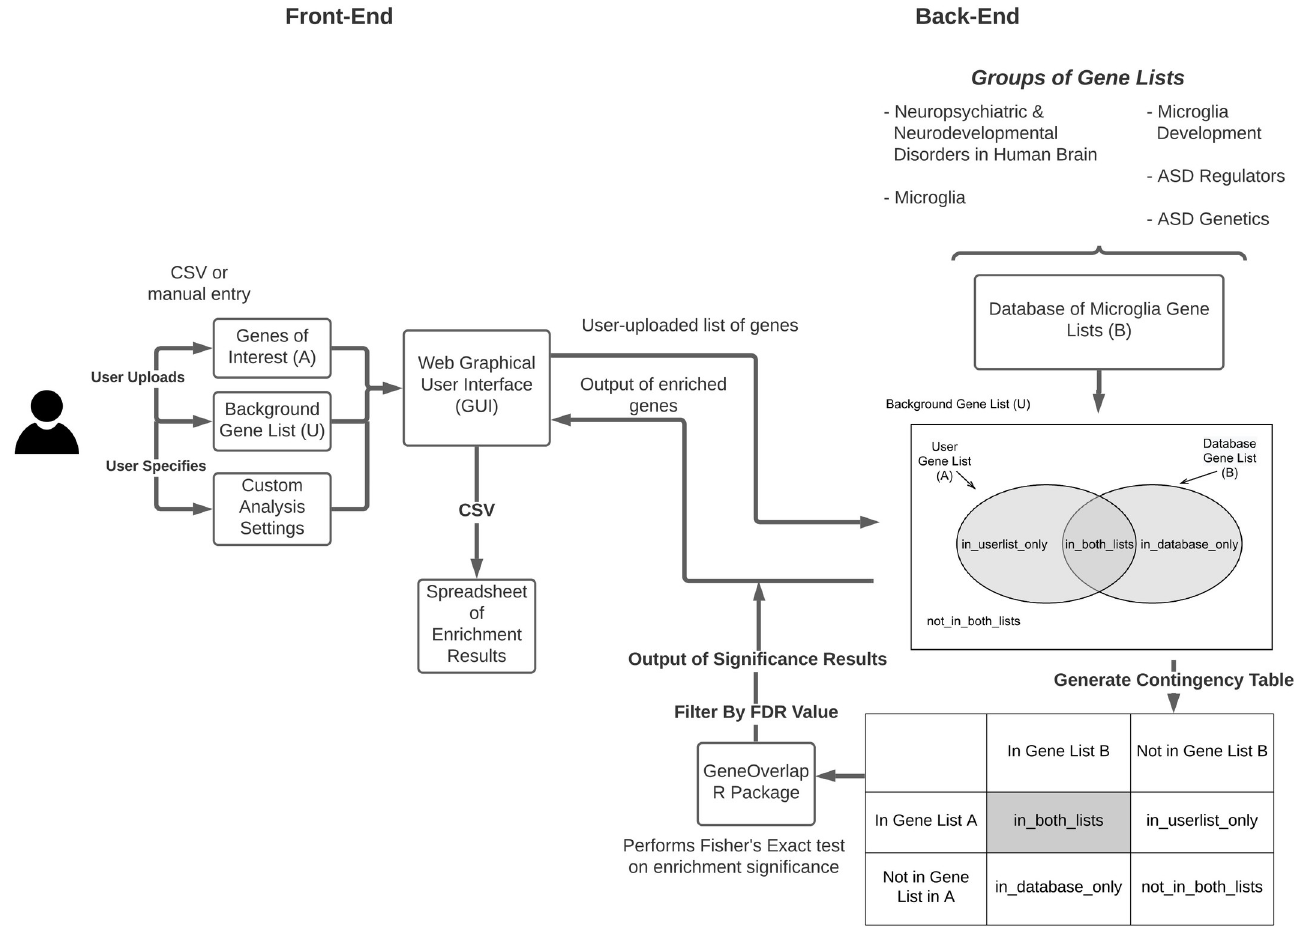
Fig 1. Model of MGEnrichment. Users can select either mouse or human gene lists and upload their gene lists of interest either through a CSV file or through entry into the GUI. The input dataset is compared against the database of microglia gene lists to determine enrichment. The GeneOverlap package is used to calculate a one-tailed Fisher’s Exact Test for enrichment in each gene list, and FDR corrected p-values are then calculated across all comparisons. The enriched gene results and corresponding statistical significance are then viewable via the GUI, or exportable via CSV. ASD = Autism Spectrum Disorder.